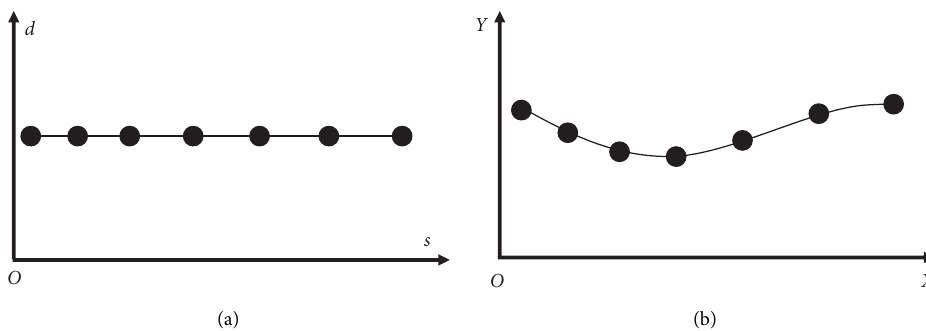
Figure 3: Representation of vehicle trajectory curve in diferent coordinate systems: (a) vehicle trajectory in the Frenet coordinate system; (b) vehicle trajectory in the global coordinate